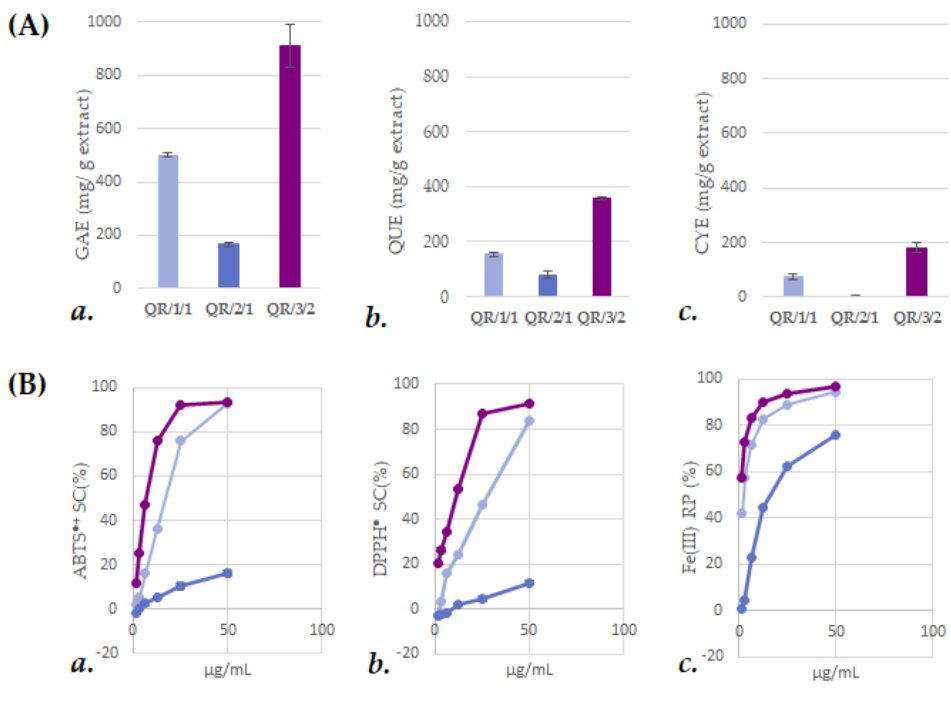
Figure 2. ( A ) a . Total phenolic content (TPC), expressed as mg of gallic acid equivalents (GAEs) per g of extract; b . total flavonoid content (TFC), expressed as mg of quercetin equivalents (QUEs) per g of extract; c . total condensed tannin content (TCT), expressed as mg of cyanin equivalents (CYEs) per g of extract. Values reported are the mean ± SD of three independent measurements. ( B ) a. Scavenging capability (SC%) vs. 2,2 ′ -azino-bis(3-ethylbenzothiazoline)-6-sulfonic acid (ABTS) radical cation; b . scavenging capability (SC%) vs. 2,2-diphenyl-1-picrylhydrazy (DPPH) radical; c . Fe(III) reducing power (RP%) of Q. robur extract and organic fractions therefrom. Values reported are the mean ±SD of three independent measurements.